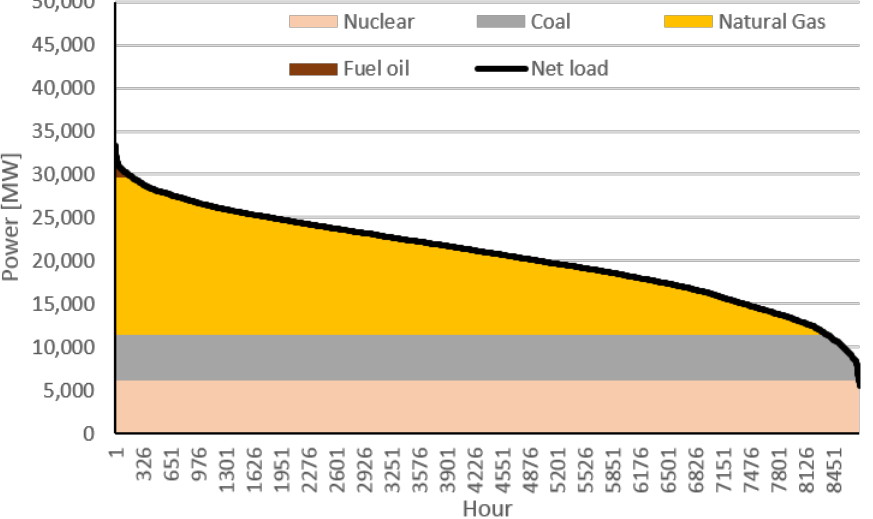
Figure 4. Iberian nRESL monotone curve and thermal technologies power division in 2018.